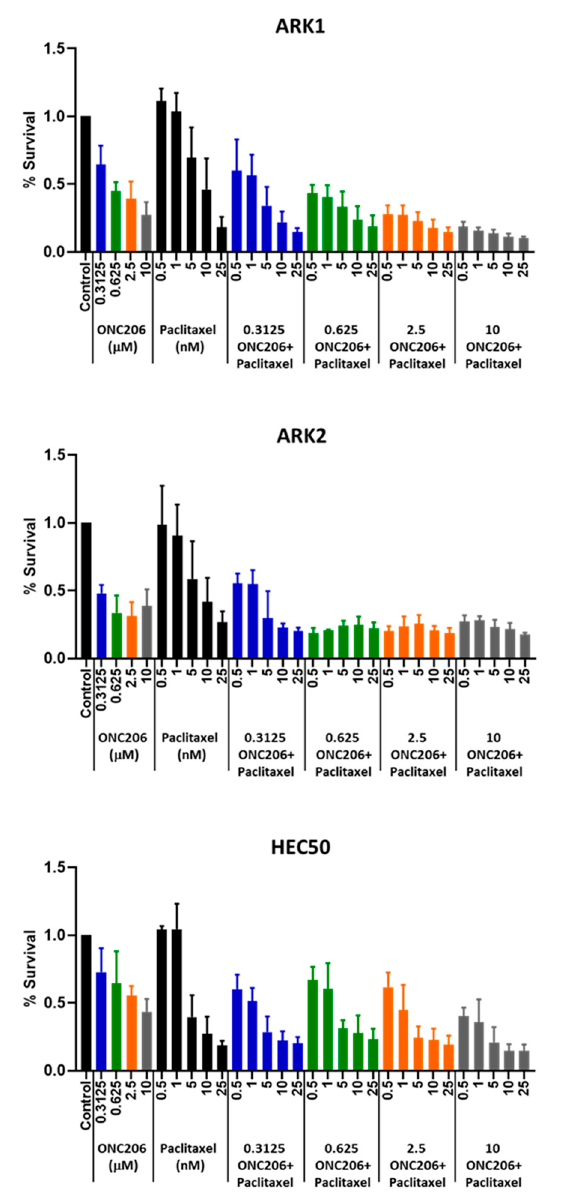
Figure 5. E ff ect of ONC206 in combination with paclitaxel on uterine serous cancer cell viability. ARK1, ARK2 and HEC50 cells were treated with ONC206 alone (0–10 µ M) or in combination with paclitaxel (0–25 nM) for 72 h. ONC206 synergized with paclitaxel in reducing cell viability of USC cells. Three independent experiments were performed (mean ± standard deviation). The combination index was calculated using CompuSyn (combination index < 1 indicates a synergistic e ff